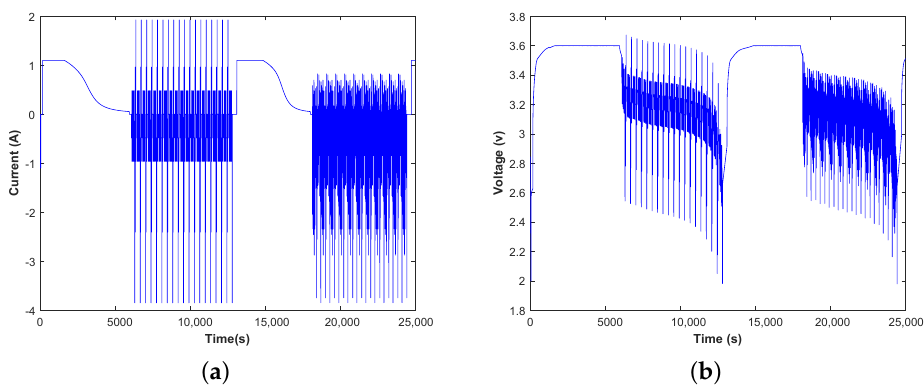
Figure 6. ( a ) Measured current and ( b ) measured voltage of the A123 LifePO 4 battery for DST profile used for the training and testing